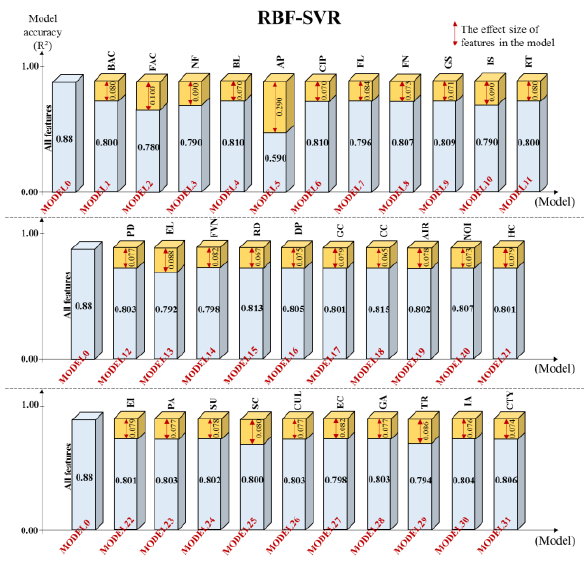
Figure 6 . Effect degrees of features in the RBF-SVR